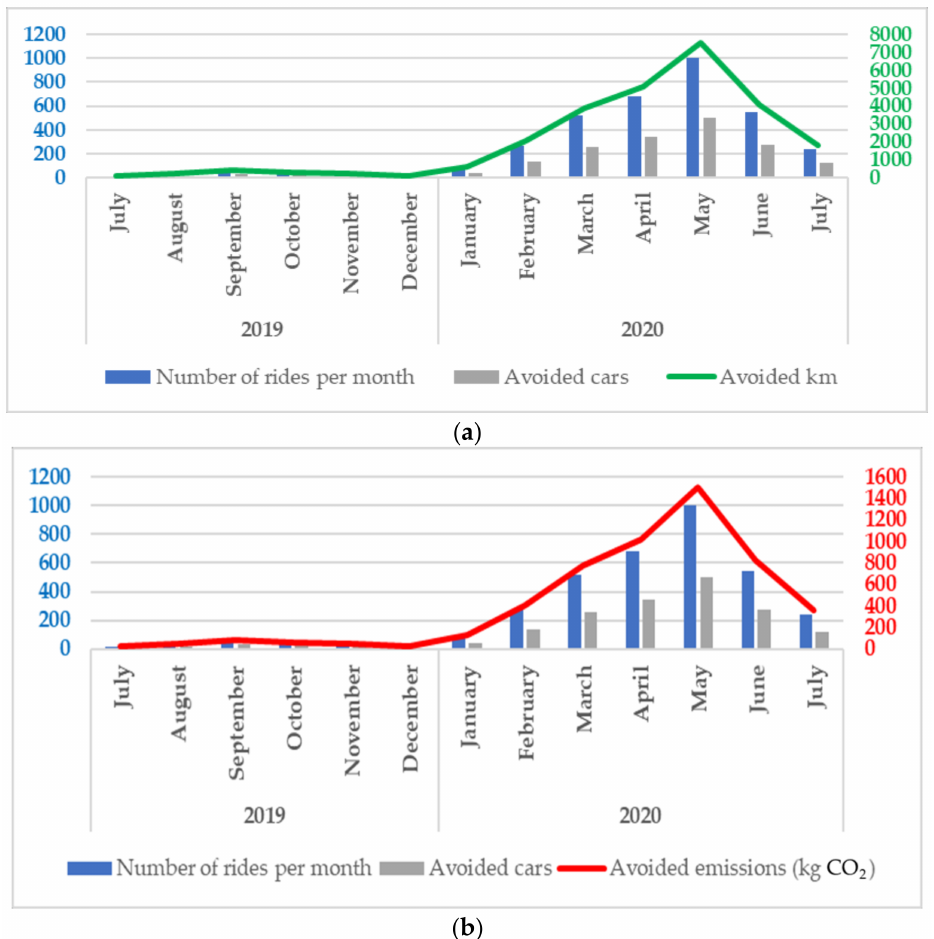
Figure 6. ( a ) Combo chart for Igoumenitsa’s BS system relating number of rides per month and avoided cars to number of avoided km. ( b ) Combo chart for Igoumenitsa’s BS system relating number of rides per month and avoided cars to number of avoided emissions (kg of CO 2 ).